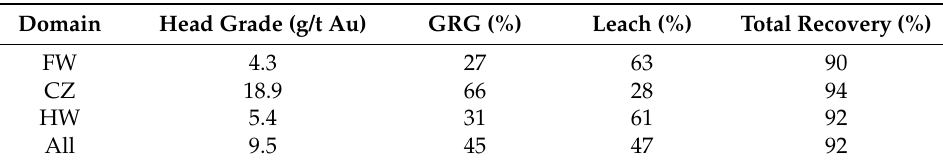
Table 11. Gold recovery by SVZ mineralisation domain.